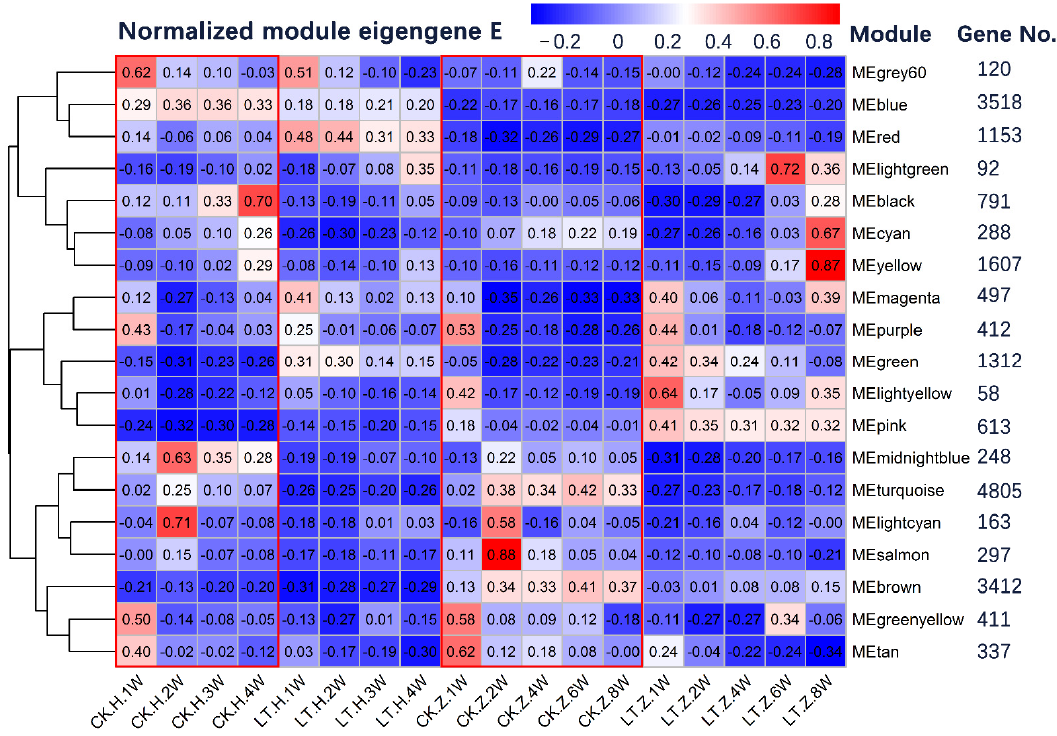
Figure 6. The gene expression pattern of different modules. The number of genes distributed in each module is indicated on the right. The modules’ relationships have been shown by K-means clustering. The color of each cell at the row-column intersection indicates module eigengene E, which is defined as the first principal component and can be considered a representative of the module’s genes expression level for a specific sample. The high expression level between a particular module and samples is indicated by dark red.